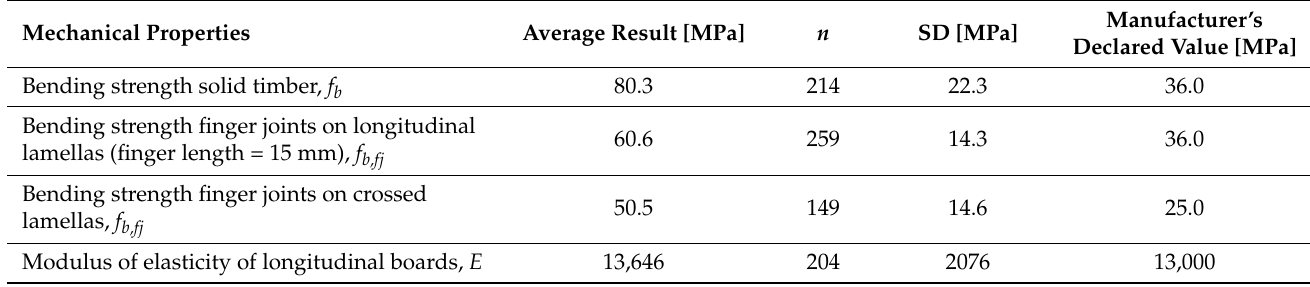
Table 2. Average strength and stiffness of the boards used in CLT